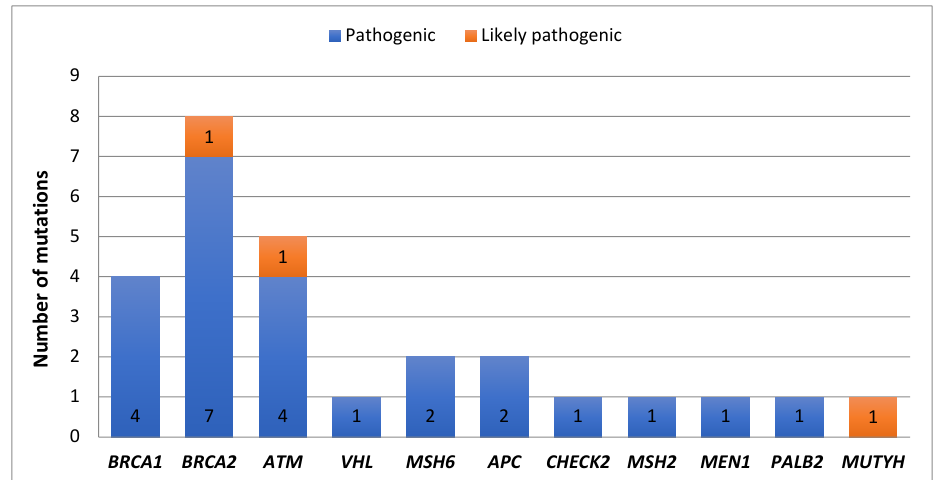
Figure 1. Distribution of pathogenic and likely pathogenic mutations identified with multi-gene panel.